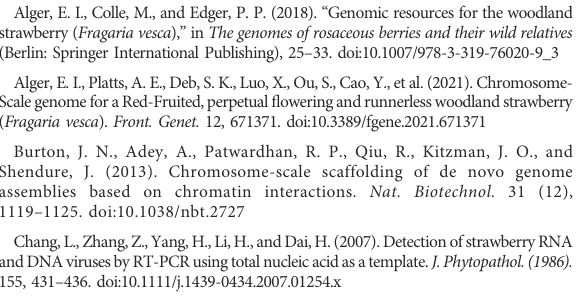
SUPPLEMENTARY FIGURE S1 SpectrumplotsforK-meranalysisestimatedbyMerqury. A :Copynumber spectrum plot for the genome assembly. The bar plotted at zero multiplicity represents base errors in the assembly. B : Assembly spectrumplotforevaluatingk-mercompleteness.K-mersarecoloredby their presence in the reads and assembly. SUPPLEMENTARY FIGURE S2 Top ten KEGG pathways from the enrichment analysis of Fragaria pentaphylla-FP039 speci fi c orthogroups. The color of column represents the p -value. The complete and detail information were showed in Supplementary Table S13. SUPPLEMENTARY FIGURE S3 Top ten KEGG pathways from the enrichment analysis of Fragaria pentaphylla-FP039 expanded orthogroups. The color of column represents the p -value. The complete and detail information were showed in Supplementary Table S14. SUPPLEMENTARY FIGURE S4 Top ten KEGG pathways from the enrichment analysis of Fragaria pentaphylla-FP039 contracted orthogroups. The color of column represents the p -value. The complete and detail information were showed in Supplementary Table S15. SUPPLEMENTARY FIGURE S5 Pictures of some relative species of Fragaria pentaphylla . A: Fragaria pentaphylla -red fruited type; B: Fragaria mandshurica ; C: Fragaria vesca -red fruited type; D: Fragaria vesca -white fruited type; E: Fragaria nilgerrensis ; F: Fragaria nubicola